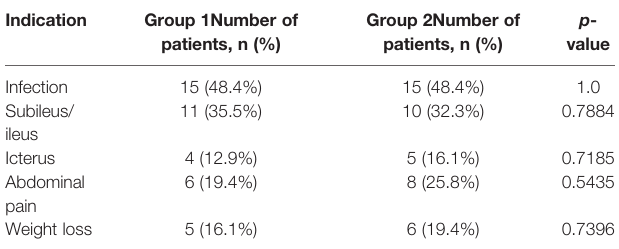
TABLE 3 | Indications for endoscopic treatment of PPPFCs. Indication Group 1Number of patients, n